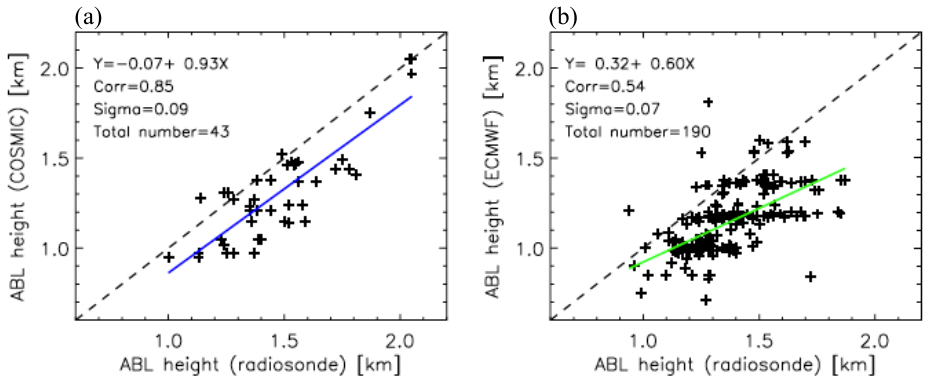
Fig. 3. (a) Scatter-plot of the ABL heights for near-coincident radiosonde (100-m smoothing) and COSMIC RO soundings with the linear fit (blue); (b) scatter-plot of the ABL heights for near-coincident radiosonde and ECMWF with the linear fit (green).